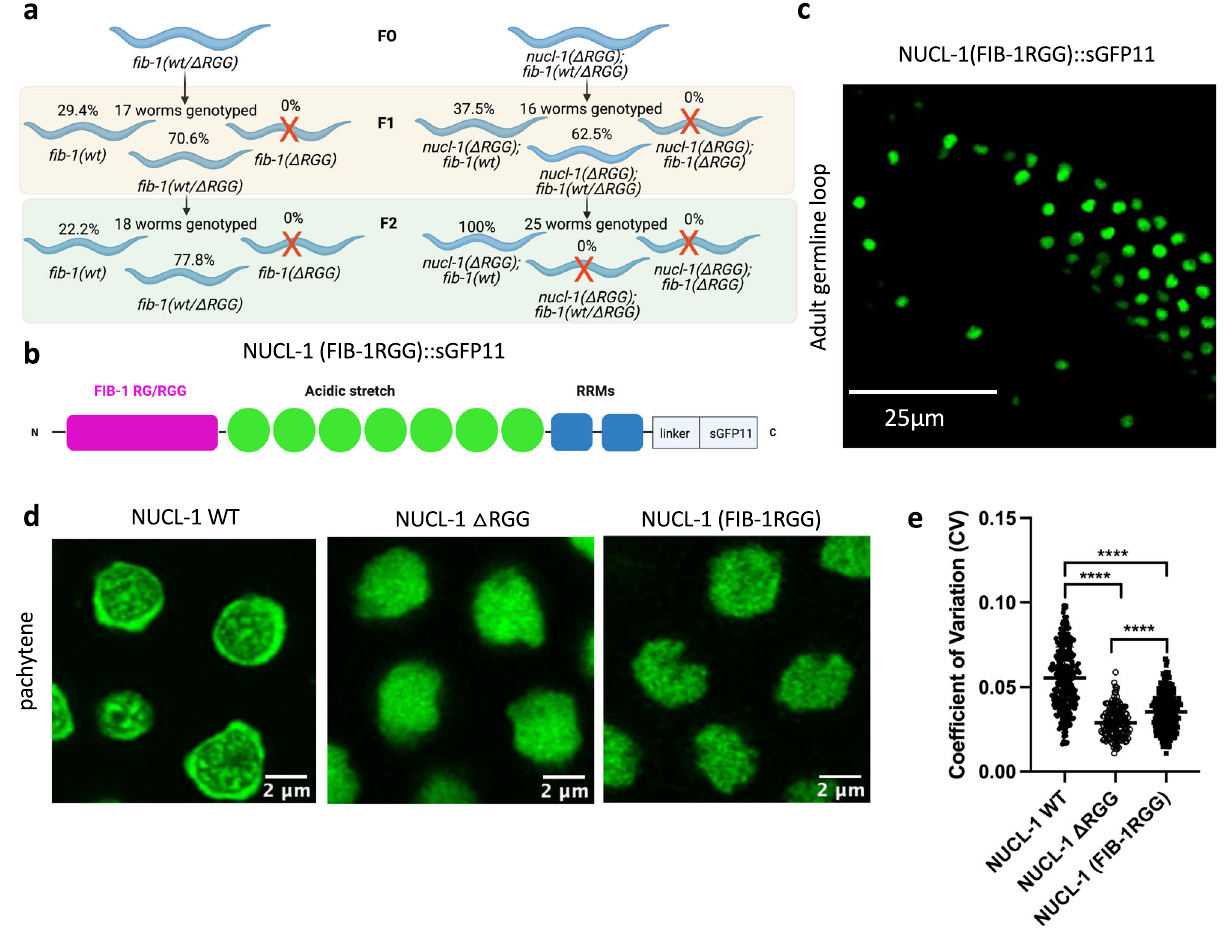
Fig. 6 | The FIB-1 RG/RGG domain shares partial genetic and functional redundancywiththeNUCL-1RG/RGGdomain.a DeletionofFIB-1RGGonNUCL-1 WT (left) and NUCL-1 Δ RGG (right) backgrounds. Red X ’ s represent non-viability. b NUCL-1(FIB-1RGG)::sGFP11 protein. c NUCL-1(FIB-1RGG) localizes to germ cell nucleoli. d Pachytene germ cell nucleoli in NUCL-1 WT, NUCL-1 Δ RGG, and NUCL- 1(FIB-1RGG)worms.NUCL-1(FIB-1RGG)proteinlackscompartmentalizationintothe